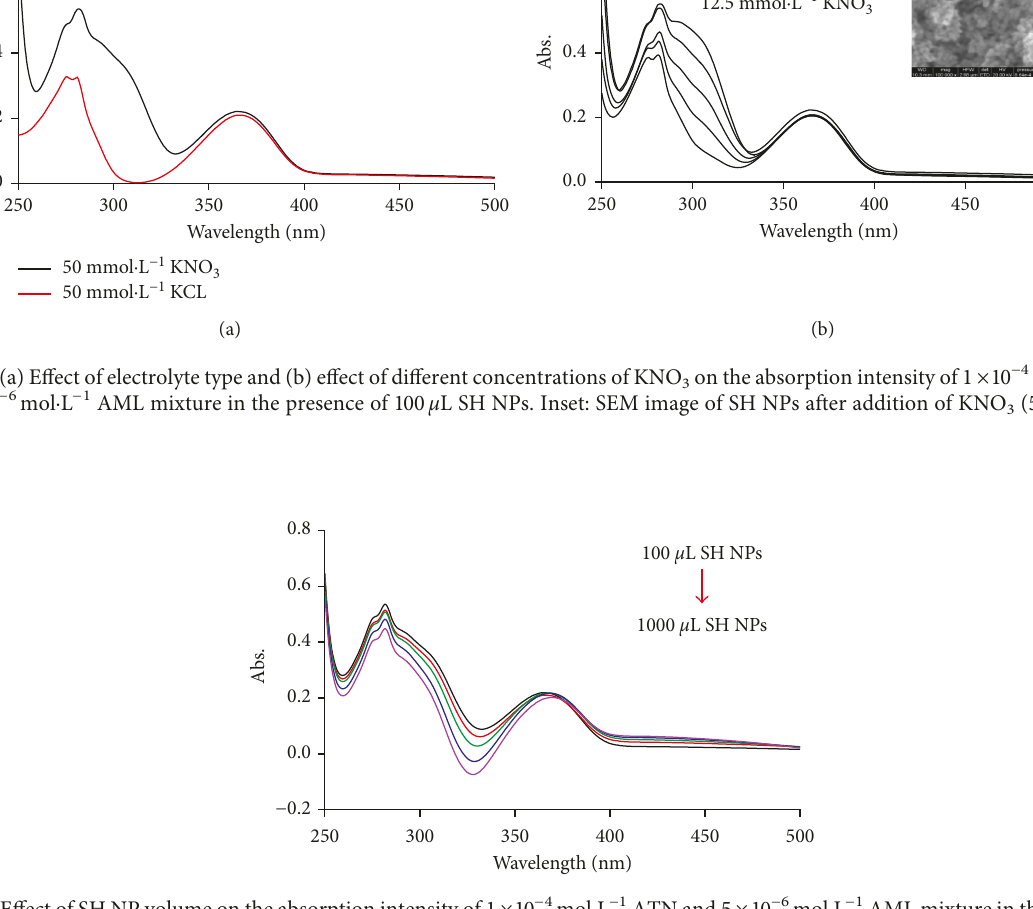
Figure 6: Effect of SH NP volume on the absorption intensity of 1 50mmol